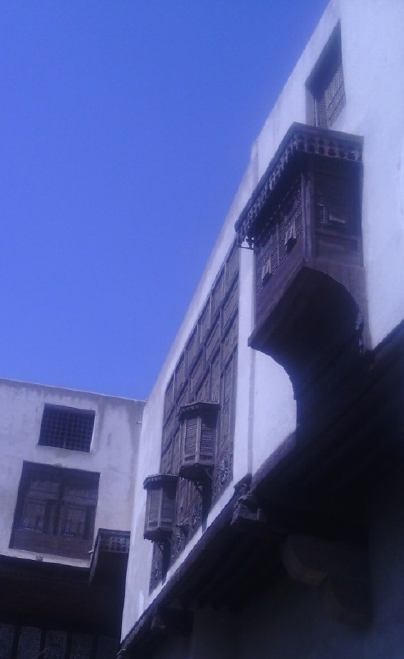
Figure 1. Wooden mashrabeyas in Old Cairene house